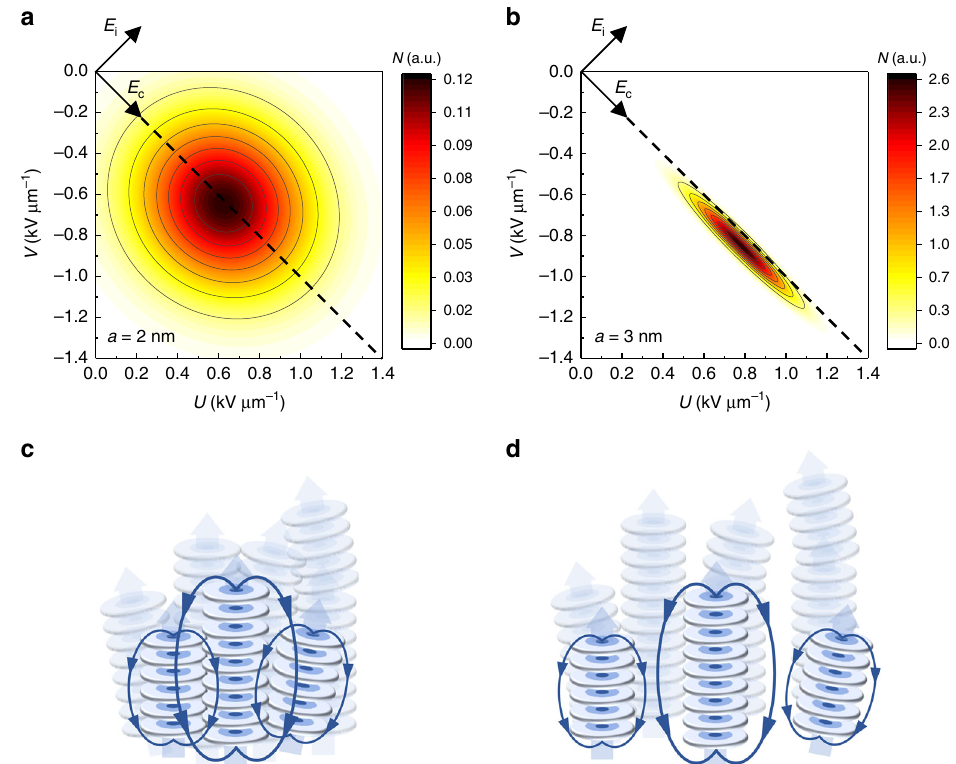
Fig. 4 Simulated Preisach distributions. The distributions are extracted from the simulated polarization switching for BTA with a columnar separation a of a 2 nm, cf. BTA, Fig. 3a and b 3 nm, cf. P(VDF-TrFE), Fig. 3b. The rotated coordinate system is shown and the dashed line indicates U = − V . c , d Illustration of the model system used for the simulations. Discs represent molecules that stack in a head-to-tail manner to form clusters. Thick transparent arrows indicate the macrodipole. The size of the clusters and the electrostatic interactions (blue lines) between them determine the form of the Preisach